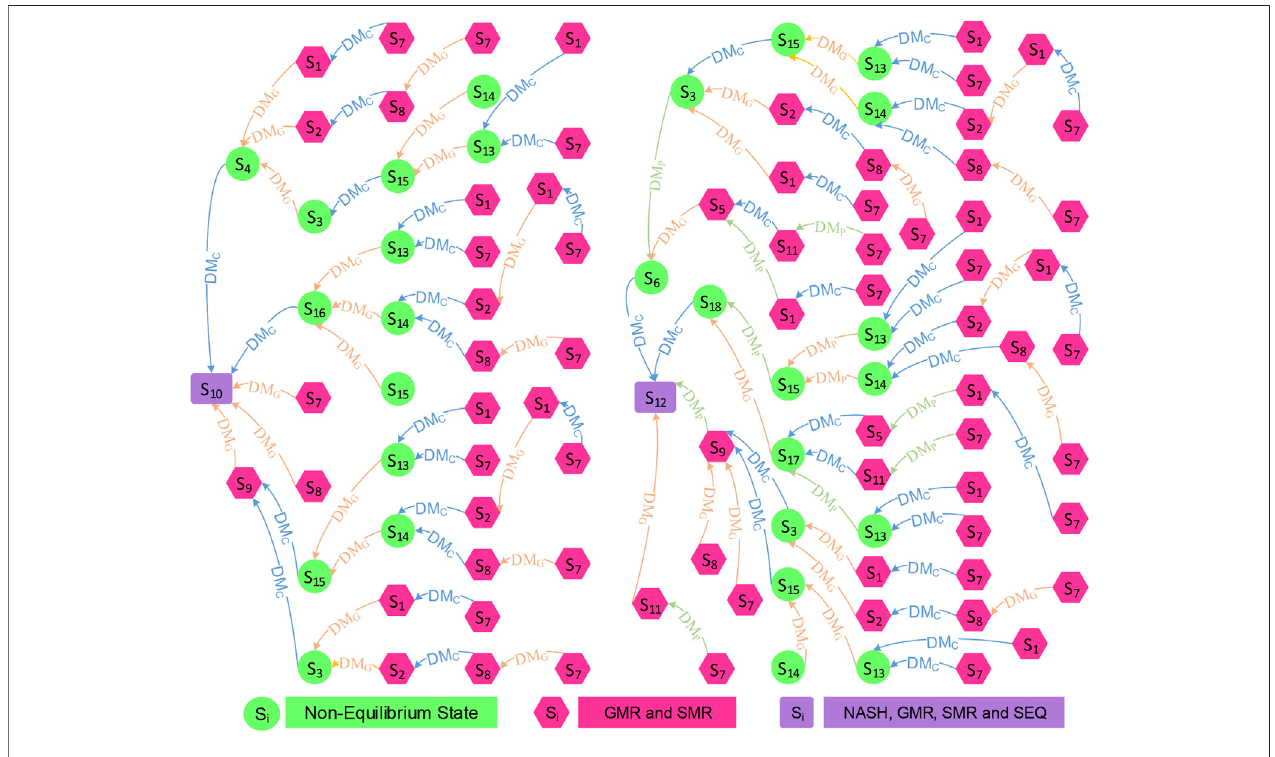
FIGURE 4 | Evolution path of con fl ict equilibrium states.